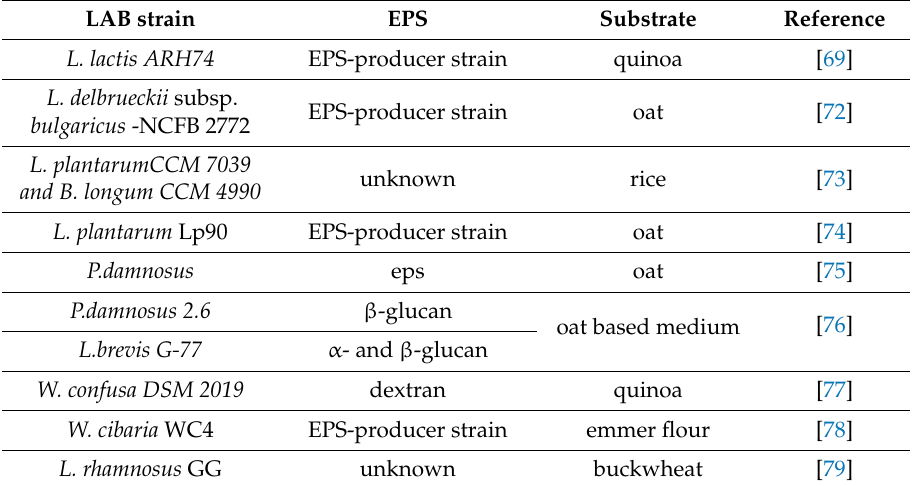
Table 2. Experimental cereal/pseudocereal-based, yogurt-like beverages with a focus on EPS-producer strains if